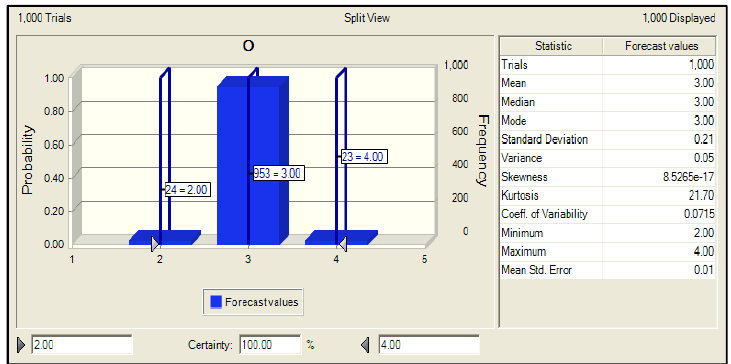
Figure 16. Case 2: Monte Carlo simulation of O in CB software.